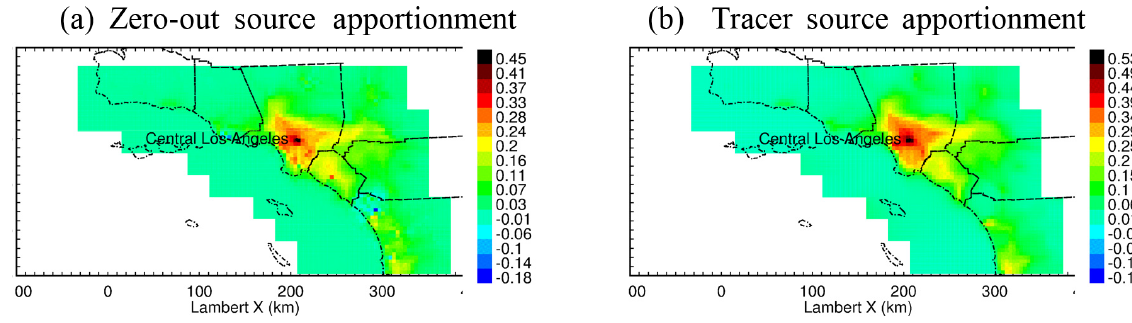
Figure 3. Particle number concentrations associated with on-road gasoline vehicles calculated using the zero-out method and the artificial tracer method in August